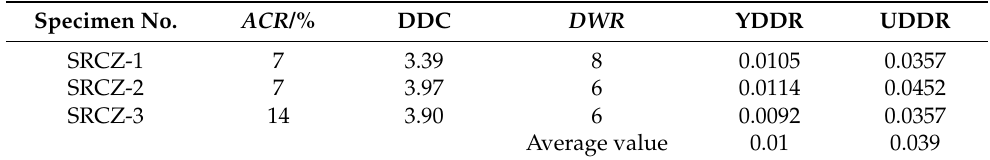
Table 4. The Ductility Results of the Test